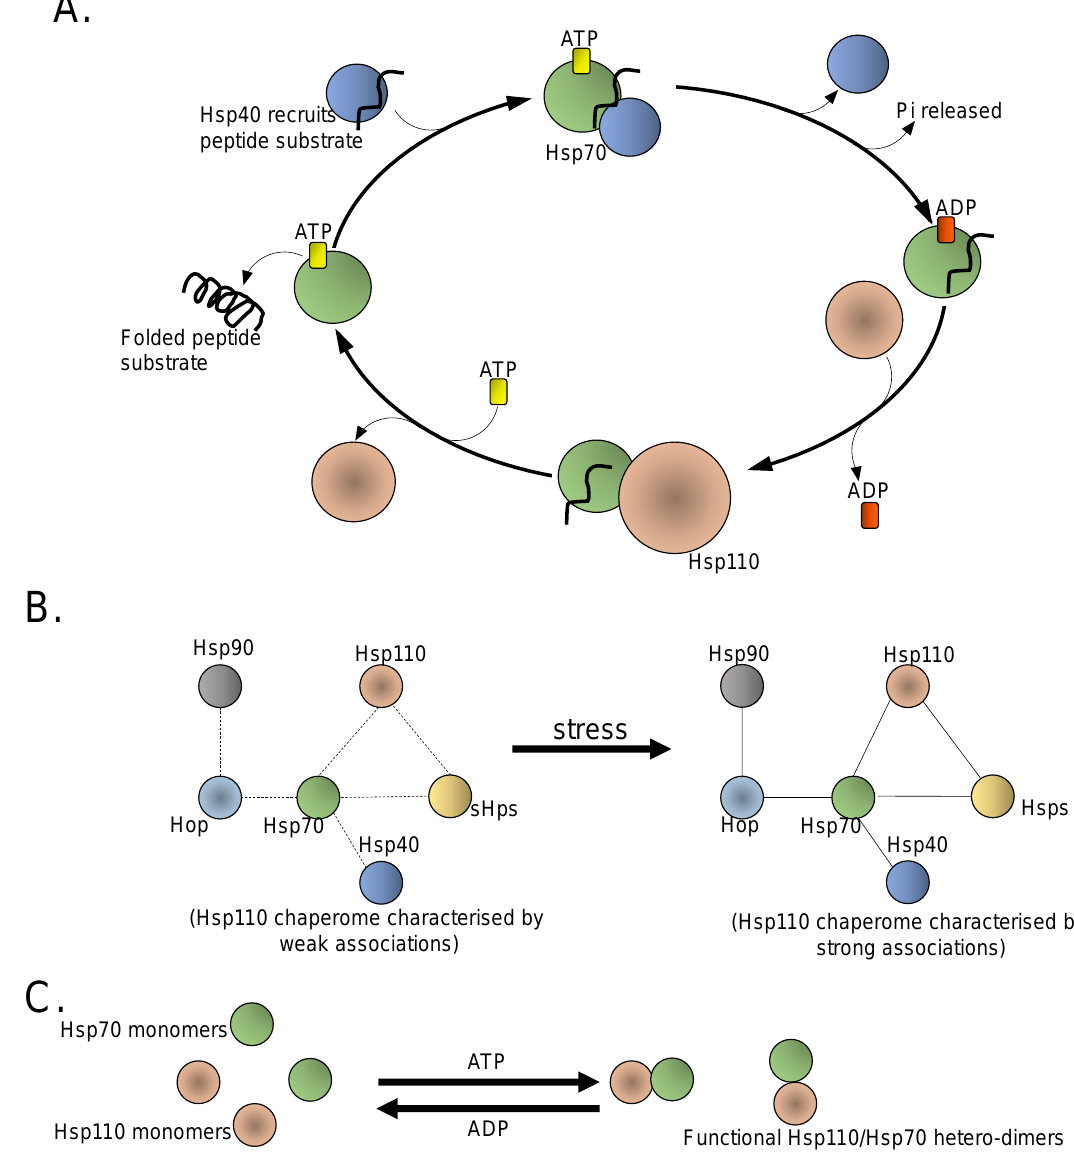
Figure 5. Hsp110 as an essential oncogenic proteome regulating chaperome: ( A ) Hsp110s facilitate exchange of ADP to ATP by canonical Hsp70, allowing release of a folded peptide. ( B ) Affinity of partners of the Hsp110 chaperome is enhanced by stress. ( C ) The formation of functional Hsp110:Hsp70 heterodimers is modulated by nucleotides.